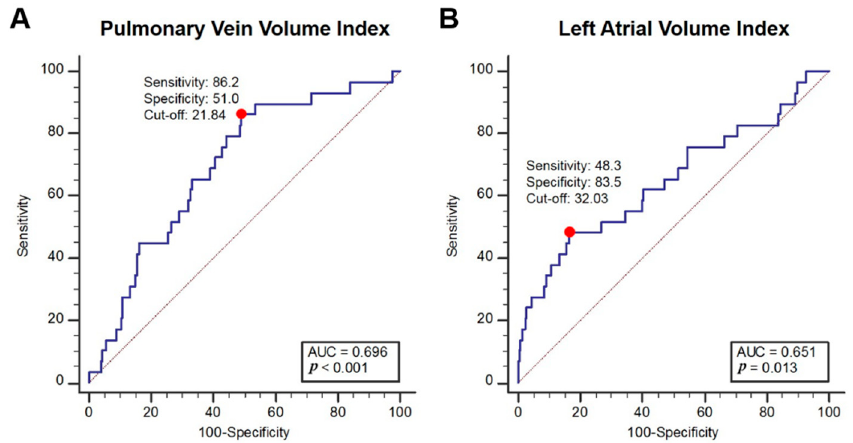
Figure 5. Receiver-operating characteristic curves of PVVI ( A ) and LAVI ( B ), for the prediction of new-onset atrial fibrillation. AUC = area under the curve, LAVI = left atrial volume index, PVVI = pulmonary vein volume index. The red-dots represent the optimal cut-off values of the volume indices.